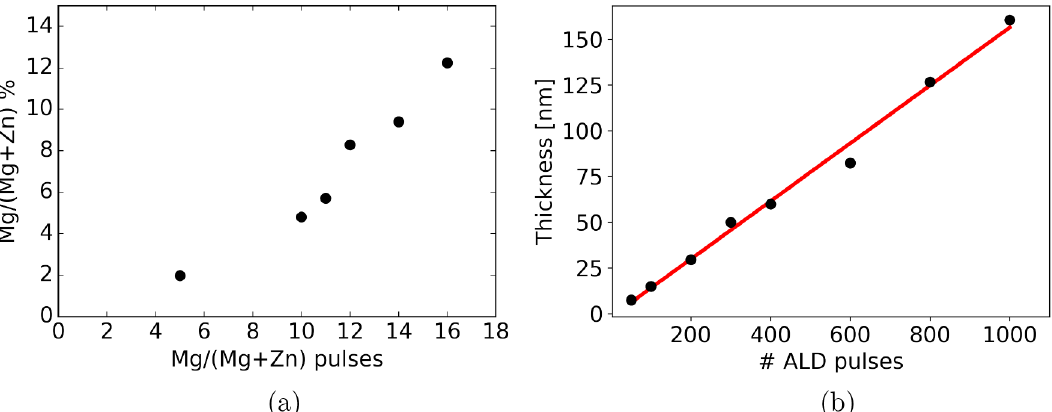
Fig. 1. (a) Mg/(Zn+Mg) content in Zn 1 (cid:1) x Mg x O fi lms as determined by XPS as function of the nominal value based on the number of pulses. (b) Zn 1 (cid:1) x Mg x O fi lm thickness with number of deposition pulses as determined by ellipsometry. A linear fi t (line) results in layer growth of 1.65 Å per